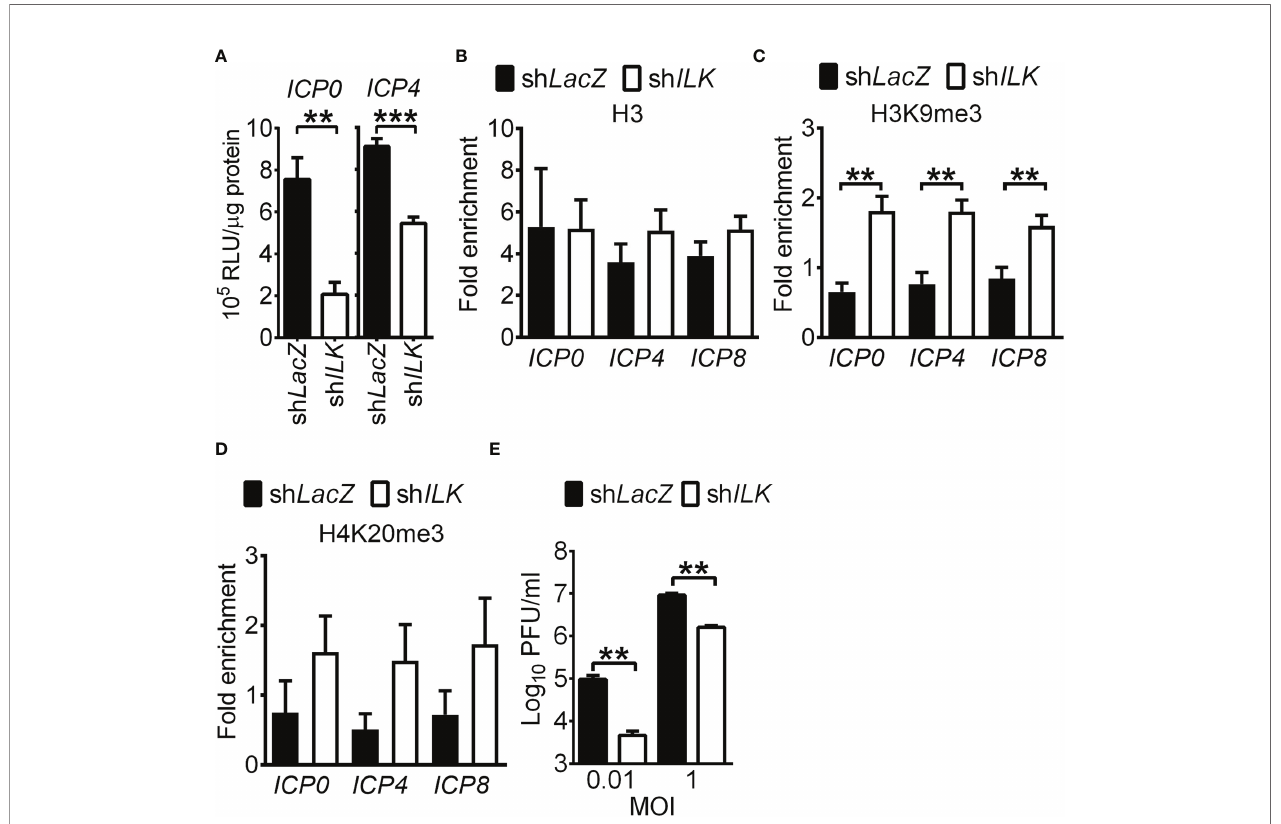
FIGURE 3 | ILK reduces H3K9me3 on HSV-1 promoters in a manner independent of ICP0. (A) The luciferase activities in uninfected control (sh LacZ ) and ILK knockdown (sh ILK ) cells transfected with pGL3 vector carrying ICP0 or ICP4 promoters are shown. (B – D) The relative levels of H3 (B) , trimethyl (me3) H3K9 (C) , and H4K20me3 (D) associated with ICP0 , ICP4 , and ICP8 promoters in control and ILK knockdown cells infected with HSV-1 at 3 hours postinfection are shown. Fold enrichment was calculated as the fraction of DNA immunoprecipitated by the speci fi c antibody/input normalized to the control antibody/input. (E) The HSV-1 yields in the control and ILK knockdown cells infected with ICP0-null virus (n212) at indicated MOI after 24 hours of infection are shown. Data represent mean + SEM (error bar). ** p < 0.01, *** p < 0.001 via Mann Whitney U test in panel E and via Student t test in the rest